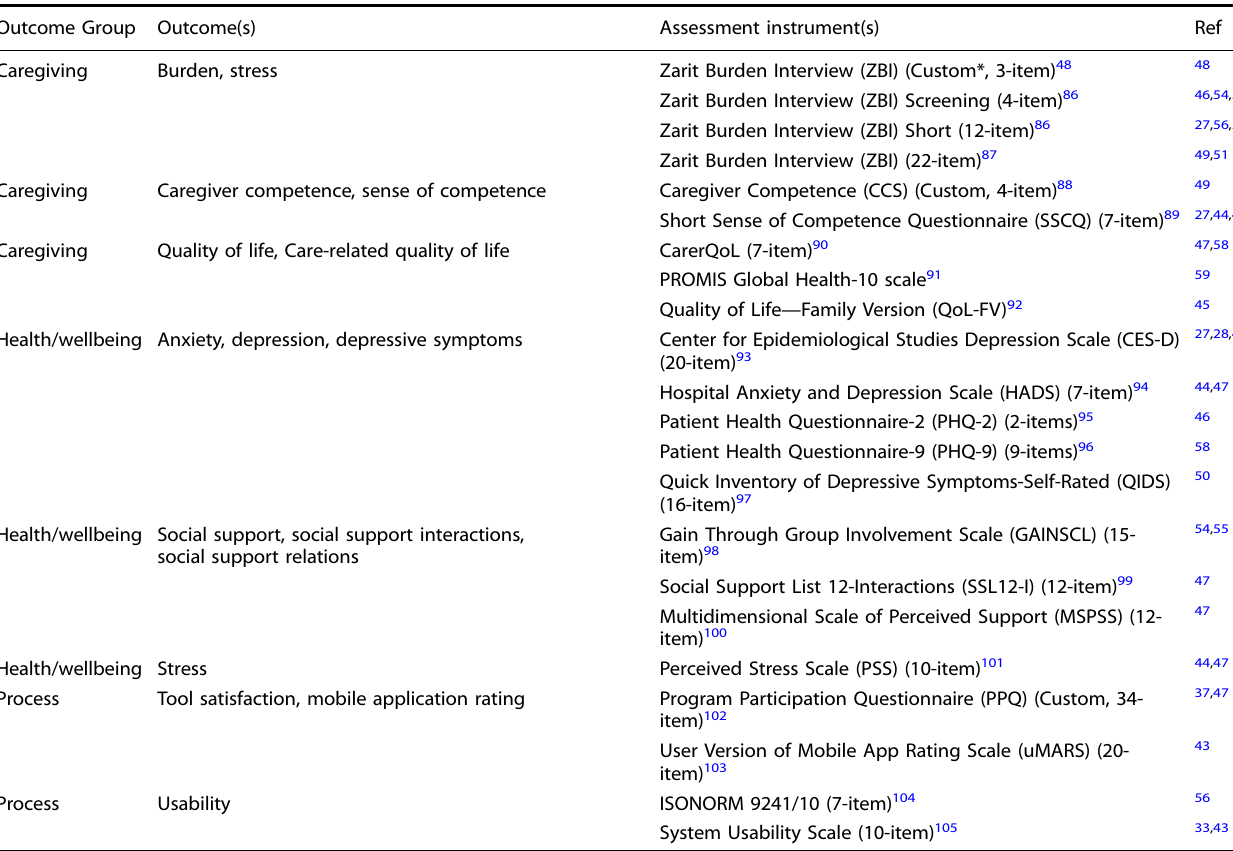
Table 4. Quantitative instruments used to explore caregiving, health/wellbeing, and process outcomes. Outcome Group Outcome(s) Assessment